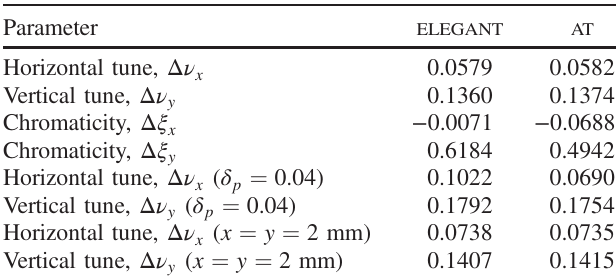
TABLE IV. Changes of lattice parameters when the quadrupole fringe field is turned off in the APS-U lattce, calculated with ELEGANT and AT .